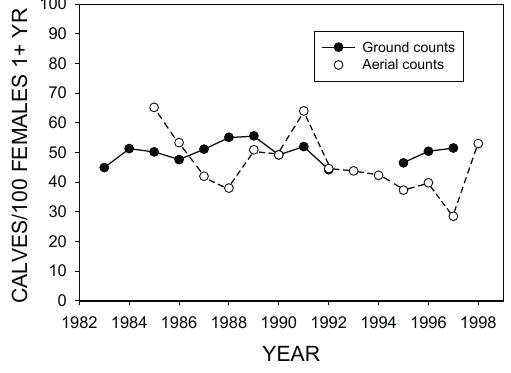
Fig. 1. Calf/100 females 1+ years was recorded from the ground during the rut in October and after the hunting season and from NINA’s air surveys in June/July in the Rondane North wild reindeer pop- ulation. Pre-hunt (August) estimates of calves/100 females 1+ years in year n were calculated by apply- ing the October group composition on population size estimates (Wegge, 1997) in February/March year n+1 , and adding the number of calves and fe- males harvested year n (Reimers,